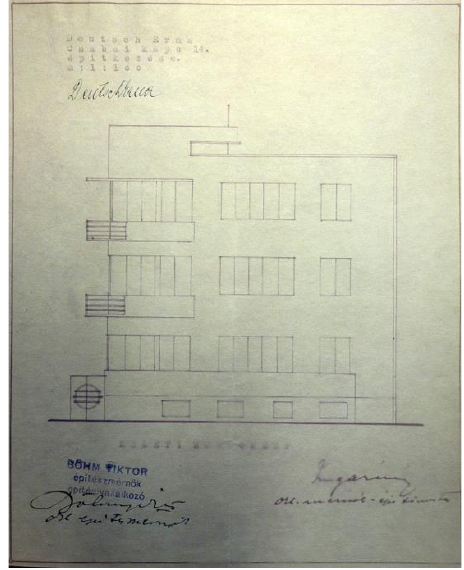
Figure 13. 16 Artúr Görgey street. Street façade. Architect: Victor Bohm, 1932 – 1934. Source: MNL Figure 13. 16 Art ú r Görgey street. Street façade. Architect: Victor Bohm, 1932–1934. Source: BAZML IV. 1906/b. 1435/1934 .